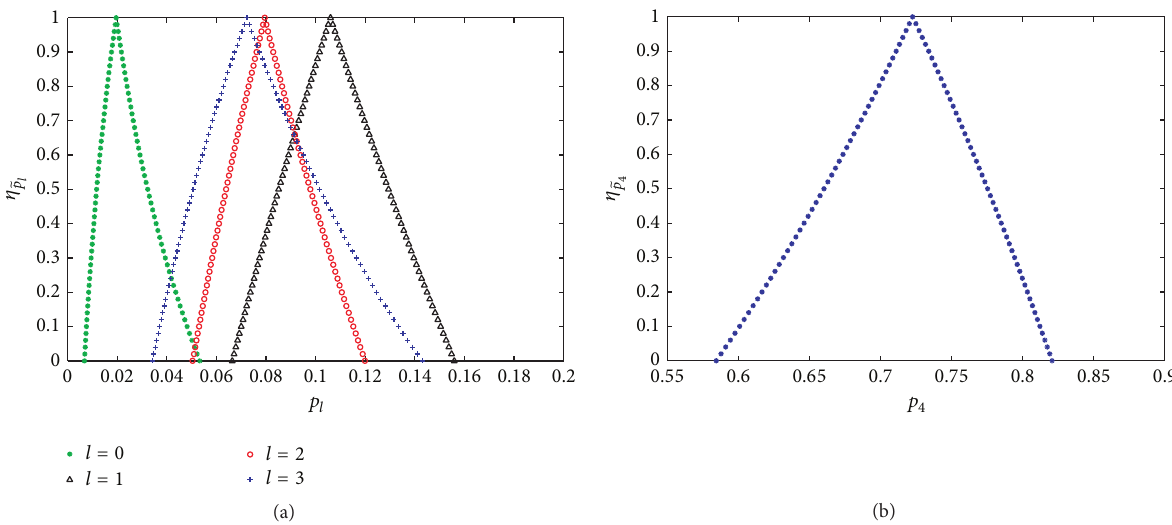
Figure 4: The membership functions for fuzzy state probabilities ̃ 𝑝 𝑙 ( 𝑙 = 0 , 1 , 2 , 3 , 4).